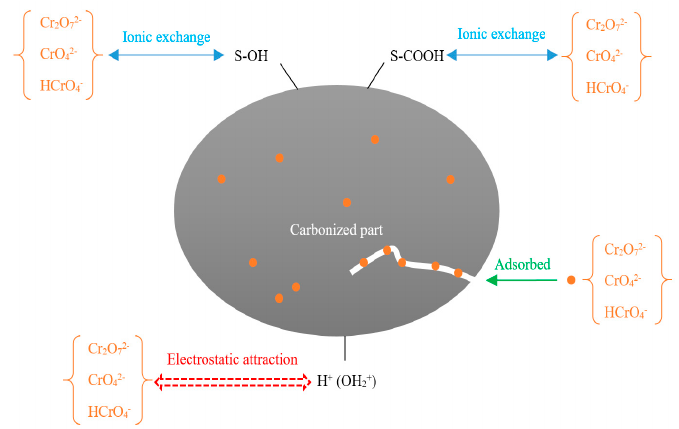
Figure 11. The proposed reaction mechanism of Cr(VI) on the FM-MBC.